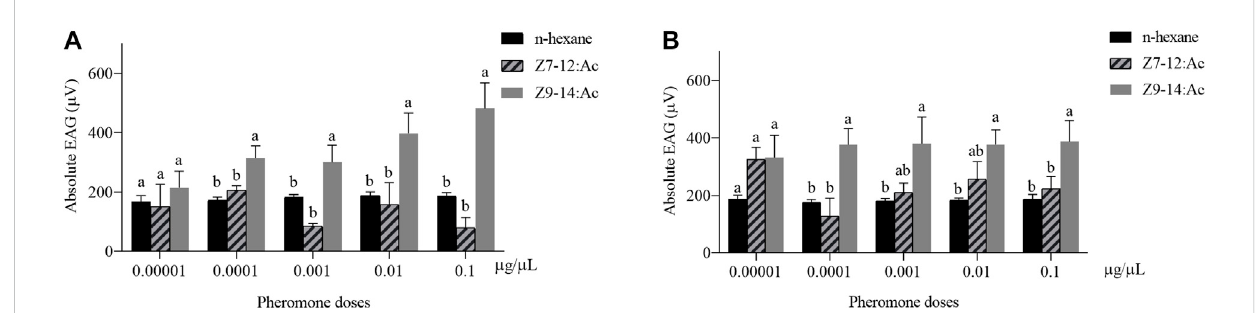
FIGURE 1 Electroantennogram (EAG) responses of male (A) and female (B) Harmonia axyridis to Z7-12:Ac and Z9-14:Ac with various doses (0.00001 – 0.1 μ g/ μ L). Six different antennae were tested as replications for each concentration. Different letters indicate signi fi cant differences between different compounds ( p < 0.05) at each concentration.